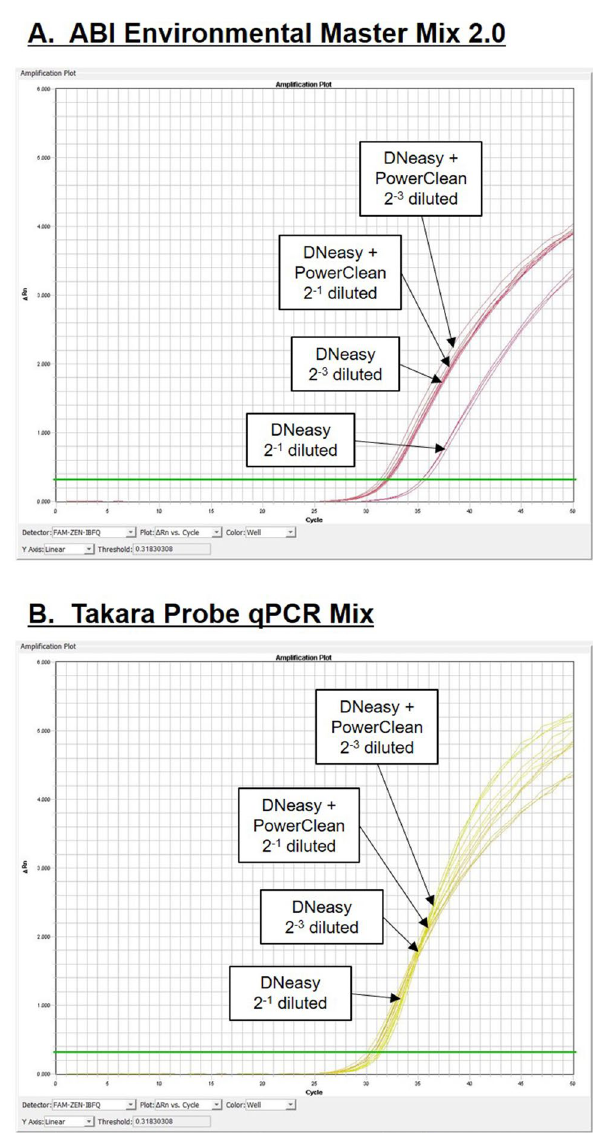
Figure 4. Correlation between PowerClean percentage purification and input calculated salmon eDNA concentration in random field water samples. No significant Pearson’s correlation was found between input eDNA concentrations and percentage purification by PowerClean